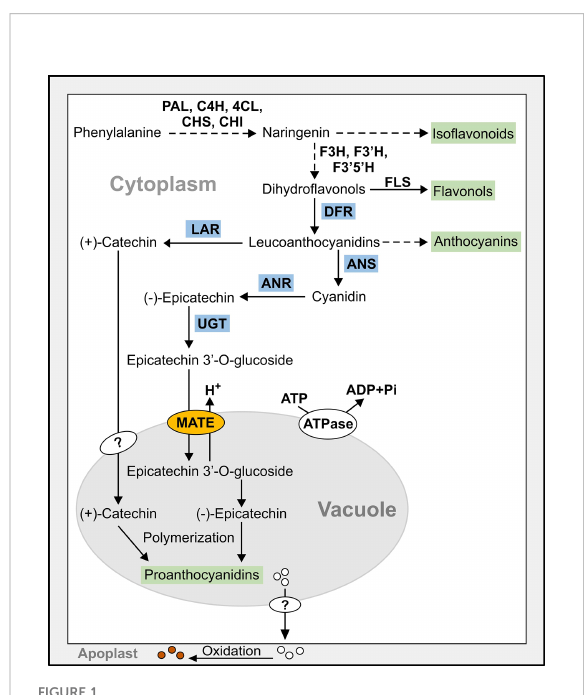
FIGURE 1 Simpli fi ed model of the fl avonoid biosynthetic pathway leading to the synthesis of proanthocyanidins (PAs) in pinto bean. Dashed line indicates multiple steps, end products are highlighted in green, and late PA biosynthetic gene encoded enzymes are highlighted in blue. 4Cl, 4-coumarate-CoA ligase; ANR, anthocyanidin reductase; ANS, anthocyanidin synthase; C4H, cinnamate-4-hydroxylase; CHI, chalcone isomerase; CHS, chalcone synthase; DFR, dihydro fl avonol reductase; F3 ’ 5 ’ H, fl avonoid 3 ′ ,5 ′ -hydroxylase; F3 ’ H, fl avonoid 3 ′ -hydroxylase; F3H, fl avanone 3-hydroxylase; FLS, fl avonol synthase; LAR, leucoanthocyanidin reductase; MATE, multidrug and toxic compound extrusion protein; PAL, phenylalanine ammonia lyase; UGT,